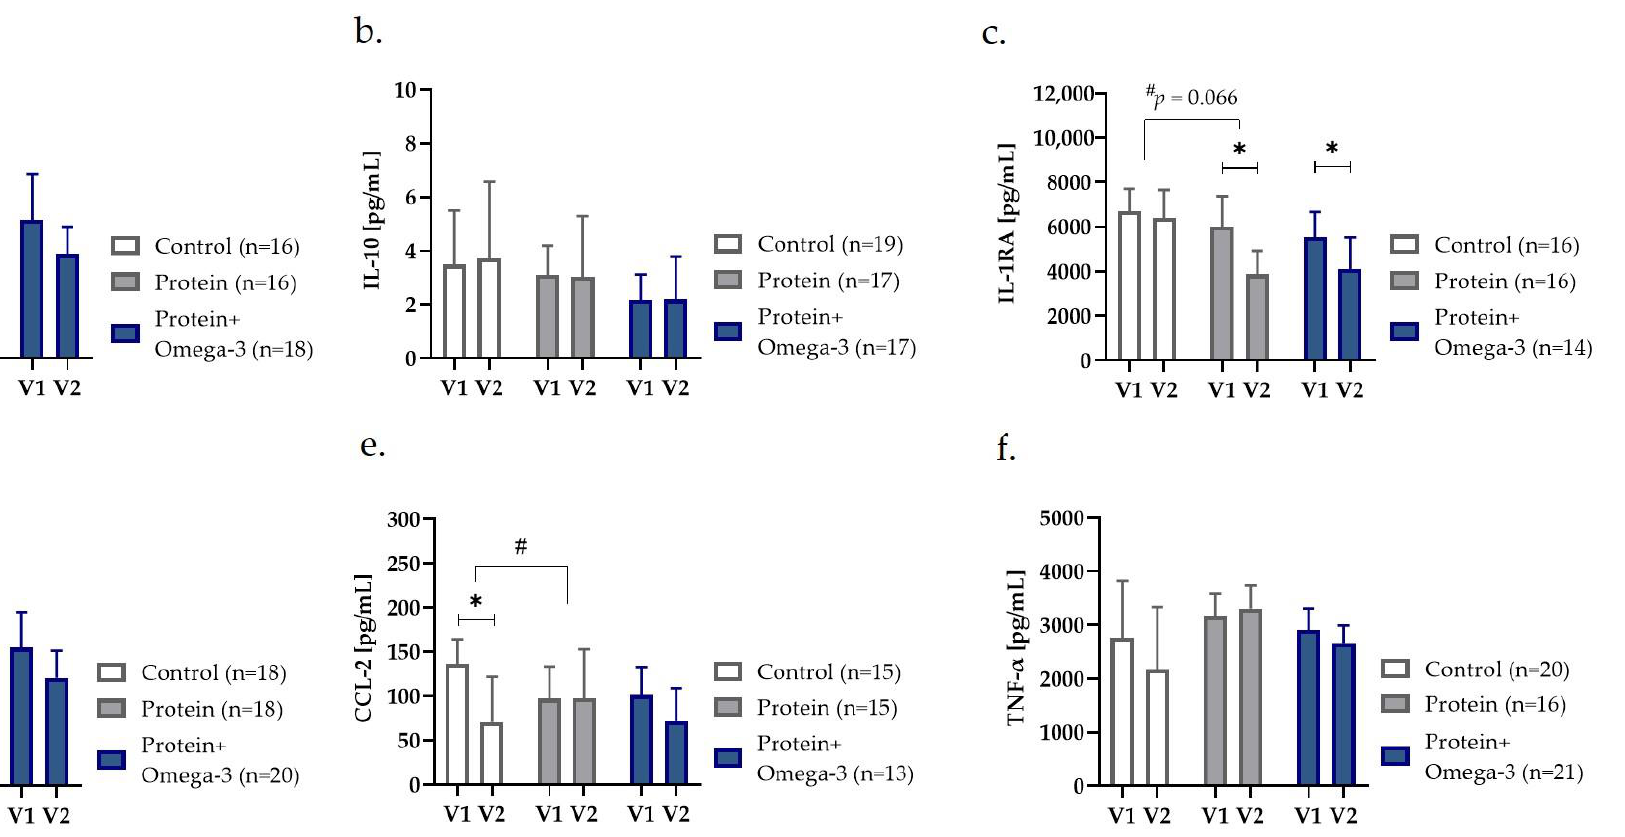
Figure 3. Ex vivo whole-blood LPS-induced concentrations of ( a ) IL-6, ( b ) IL-10, ( c ) IL-1RA, ( d ) IL-1 β , ( e ) CCL-2, and ( f ) TNF- α presented as estimated mean with 95% confidence interval before (V1) and after (V2) eight weeks of control, high-protein (protein) or high-protein, omega-3-enriched (protein + omega-3) diet. * p < 0.05 obtained from within-group comparisons with either paired t-test or Wilcoxon rank test, and # p < 0.05 indicating group × time-interaction effects between groups in generalized linear mixed models with random effects on subjects, adjusted for age, sex, and fat mass index. CCL-2 c-c motif chemokine ligand-2; IL interleukin, RA receptor antagonist; TNF-α tumor necrosis factor-α.